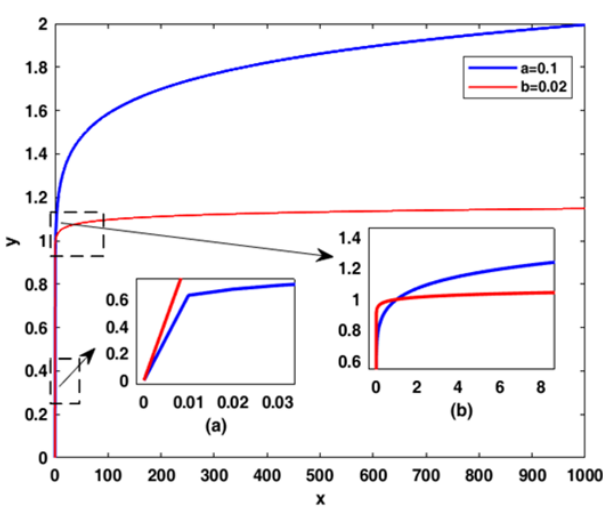
Figure 8. Function results of y = | x | a and y = | x | b : ( a ) multiple of the speed reduction, ( b ) multiple of the speed increase.